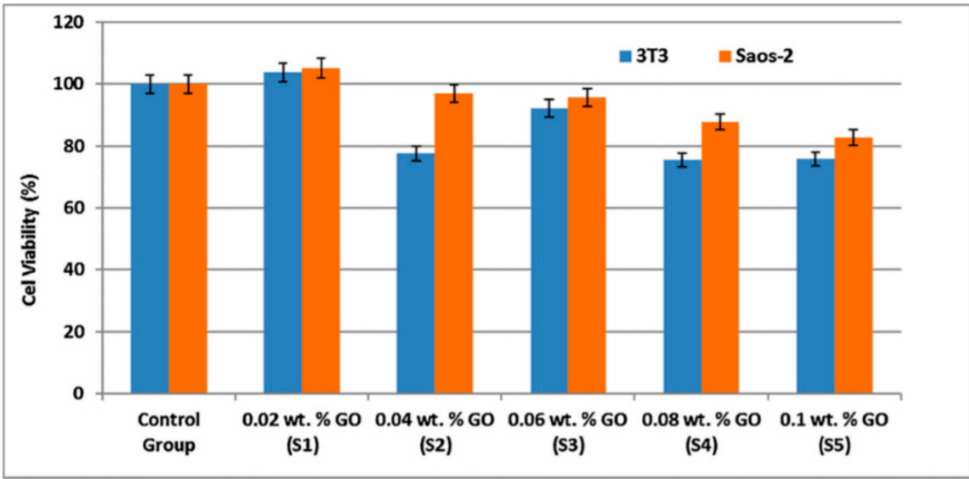
Figure 4. Schematic illustration for the MTT results of the living cells after 24 h